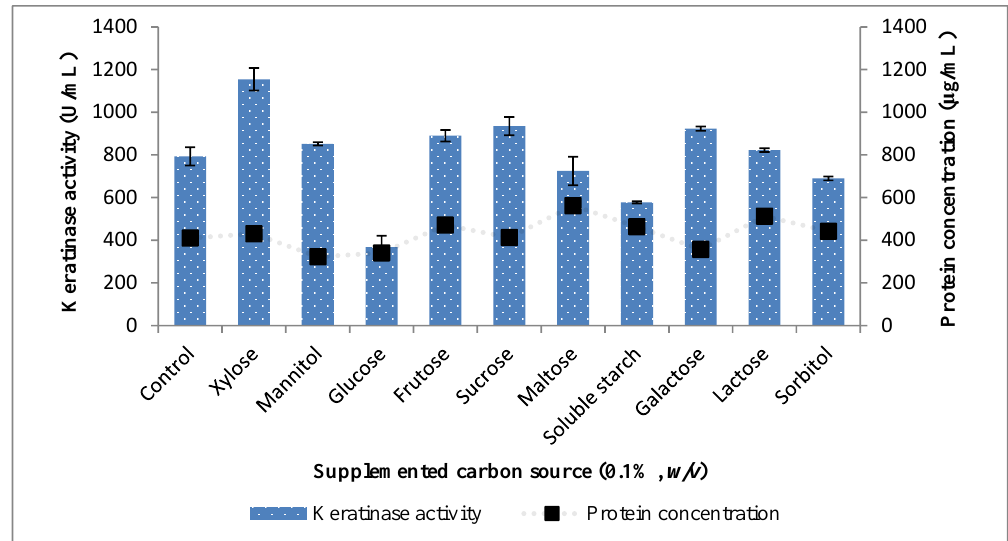
Figure 3. The influence of saccharide supplementation of medium for enhanced keratinase activity by Bacillus sp. FPF-1.